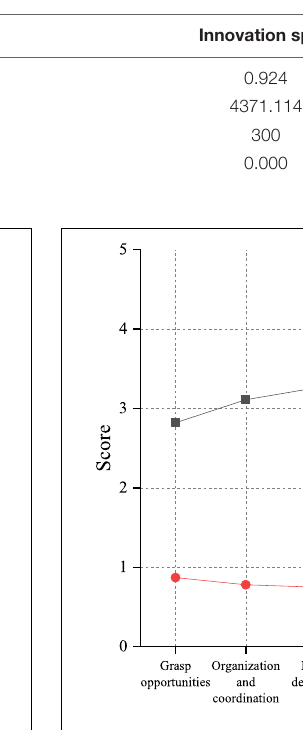
FIGURE 6 | Analysis of college students’ innovation capability. other five dimensions are in the middle level. Students has the highest level in the strategic decision-making ability ( M = 3.264, SD = 0.749).